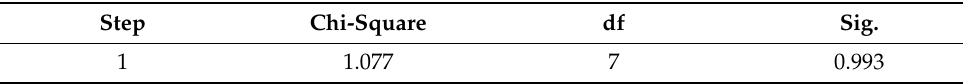
Table A2. Hosmer and Lemeshow test results.